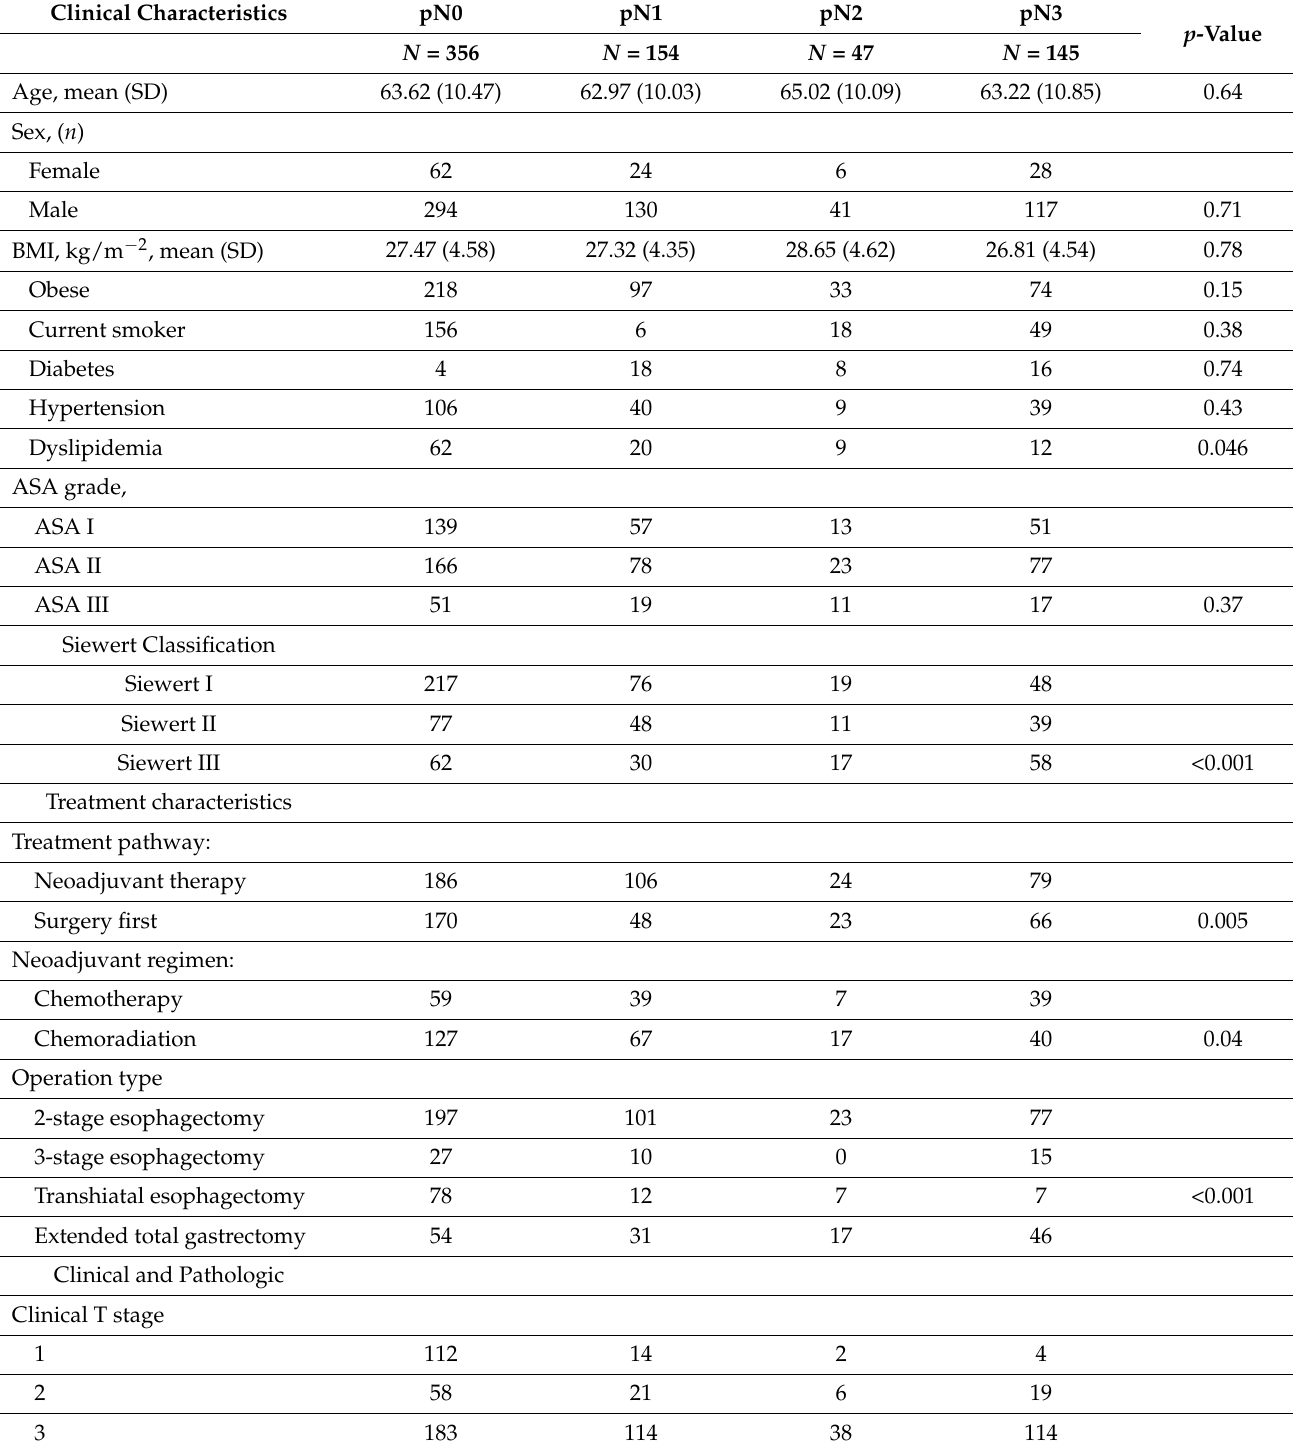
Table 1. Clinical characteristics for patient cohort included in